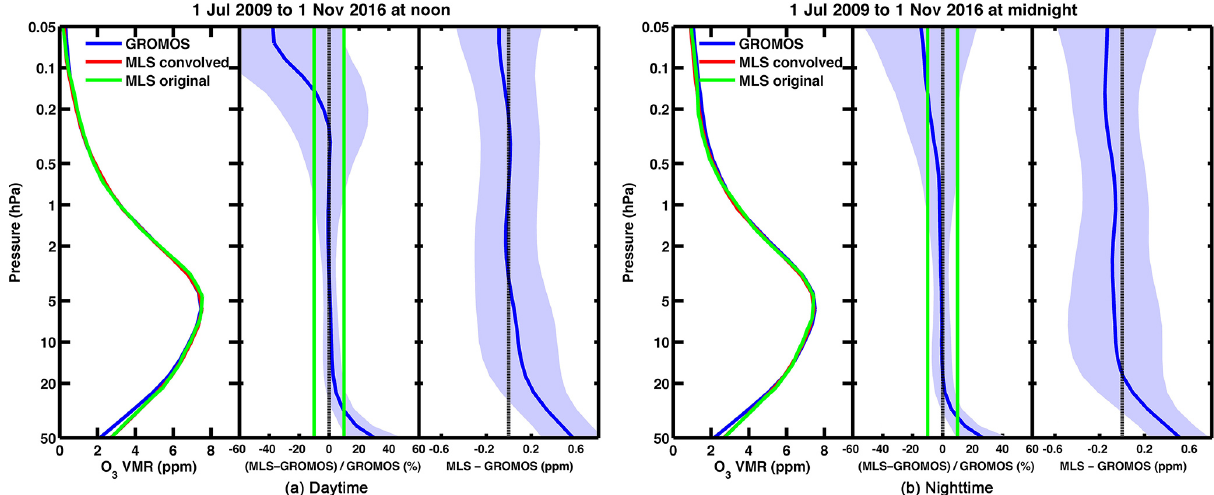
Figure 3. Mean ozone profiles recorded by GROMOS (blue line), MLS convolved (red line), and MLS original (green line) for the time interval between July 2009 and November 2016 are shown in the left sections of both the daytime (a) and nighttime (b) panels. The blue area (GROMOS) and the red area (MLS) are the SDs of the coincident measurements. The middle sections show the mean relative difference profile between data of both instruments, with GROMOS as reference. The blue areas in the middle sections represent the SD of the differ- ences. The green lines in the middle sections delimit the ± 10% area. The mean VMR difference profile and its SD (blue area) are displayed in the right-hand parts of the daytime and nighttime